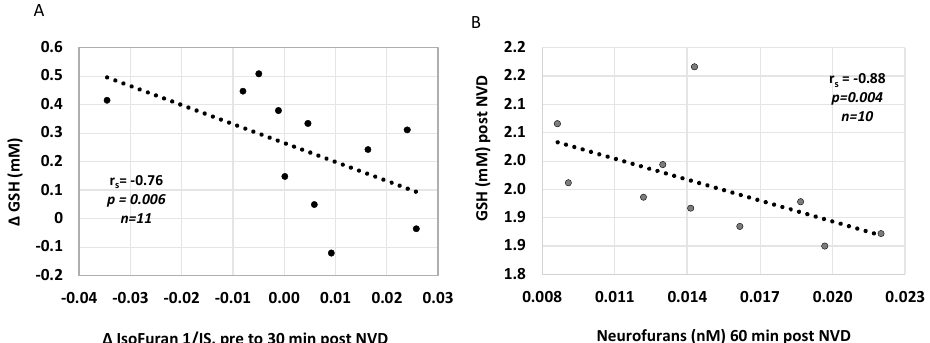
Figure 5. Plasma oxidative stress markers Isofurans and Neurofurans correlate with CNS [GSH] after NVD. ( A ) The increase in [GSH] is strongly correlated with a decrease in Isofurans from pre to post NVD dosing. ( B ) [GSH] after NVD infusion is strongly negatively correlated with Neurofurans at 60 min post infusion. (Spearman’s rank correlation).